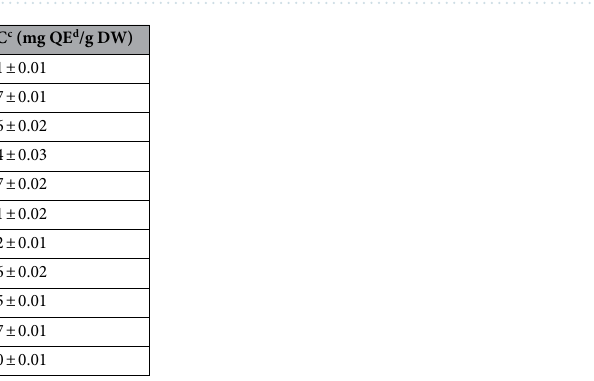
Figure 1. HPLC chromatogram of Thymus trautvetteri . The polyphenolic compounds were described in footnote. Footnote: 1: gallic acid, 2: epicatechin, 3: chlorogenic acid, 4: caffeic acid, 5: luteolin-7-o-glucoside, 6: p-coumaric acid, 7: ferulic acid, 8: cinnamic acid, 9: rosmarinic acid, 10: salvianolic acid, 11: apigenin, 12: naringenin, 13: kaempferol.